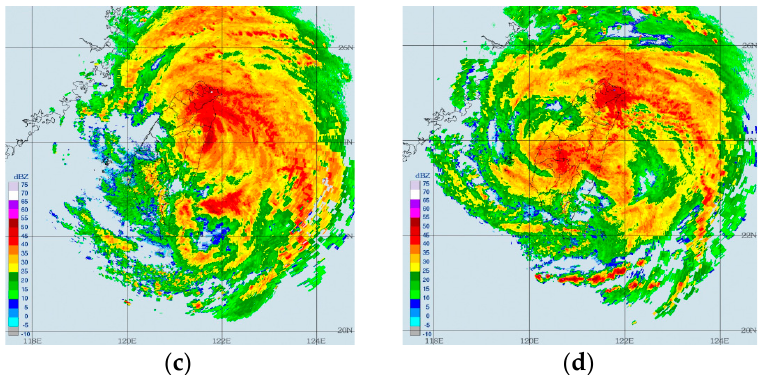
Figure 3. Radar reflectivity (dBZ) derived from the Central Weather Bureau (CWB) Doppler radar network on 7 August at ( a ) 12:00 UTC, ( b ) 18:00 UTC, ( c ) 20:40 UTC and ( d ) 23:10 UTC, during landfall.